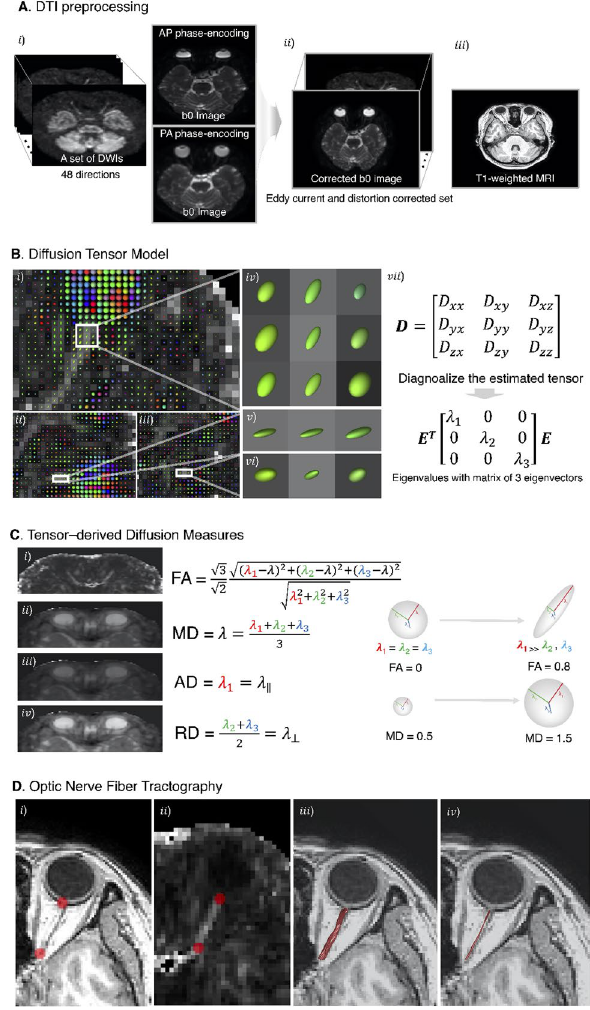
Figure 1. Overview of diffusion tensor imaging (DWI) analysis. ( A ) Preprocessing of raw DWI data. A set of 50 images was acquired from each participant, including 48 sampling directions and two b0 images of anteroposterior (AP) and posteroanterior (PA) phase-encoding directions ( i ). One corrected b0 image was generated, and the entire diffusion data was applied by estimating artifacts from two pairs of b0 images ( ii ). Finally, a set of 49 images was co-registered to the T1 image ( iii ). ( B ) Diffusion tensor model. To represent the optic nerve in the axial ( i ), sagittal ( ii ), and coronal ( iii ) views on the FA image, diffusion directionality was color-coded with green representing anterior–posterior directions, red representing left–right directions, and blue representing superior-inferior directions for a single subject using FSL eyes. A close-up view of 3 × 3 voxels of the optic nerve behind the eye globe in the axial ( iv ), three voxels in the sagittal ( v ), and three voxels in the coronal views ( vi ). The diffusion tensor D was estimated from a set of DWIs. The three orthotropic axes of a diffusion ellipsoid can be determined by the decomposition of the tensor into eigenvectors and eigenvalues ( vii ). ( C ) Tensor-derived diffusion measures. Cropped image of the fractional anisotropy (FA) ( i ), mean diffusivity (MD) ( ii ), axial diffusivity (AD) ( iii ), and radial diffusivity (RD) ( iv ). FA values are bounded between zero (a perfect sphere) and one (an infinitely long cigar shape). MD is the mean of the eigenvalues of the diffusion tensor. AD indicates an eigenvalue of λ 1 , which is diffusivity along the principal axes, while RD is diffusivity along non-principal axes by averaging the eigenvalues of λ 2 and λ 3 . ( D ) Optic nerve fiber tractography. Two spherical regions of interest (ROIs) are placed posterior to the globe of the eye and in the orbital apex at the center of the annulus of Zinn to identify the optic nerve pathway. Placement of the two ROIs overlaid on T1 ( i ) and FA image ( ii ). Visualization for cleaned optic nerve tractography ( iii ) and a central fiber in the optic nerve passing through the ROI ( iv